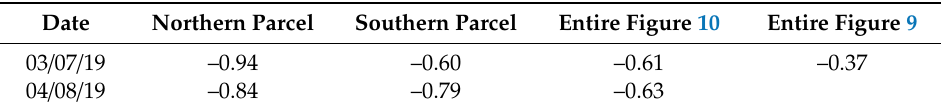
Table 6. Correlation coe ffi cients between SB temperature and ETa over the experimental field and areas represented in Figures 9 and